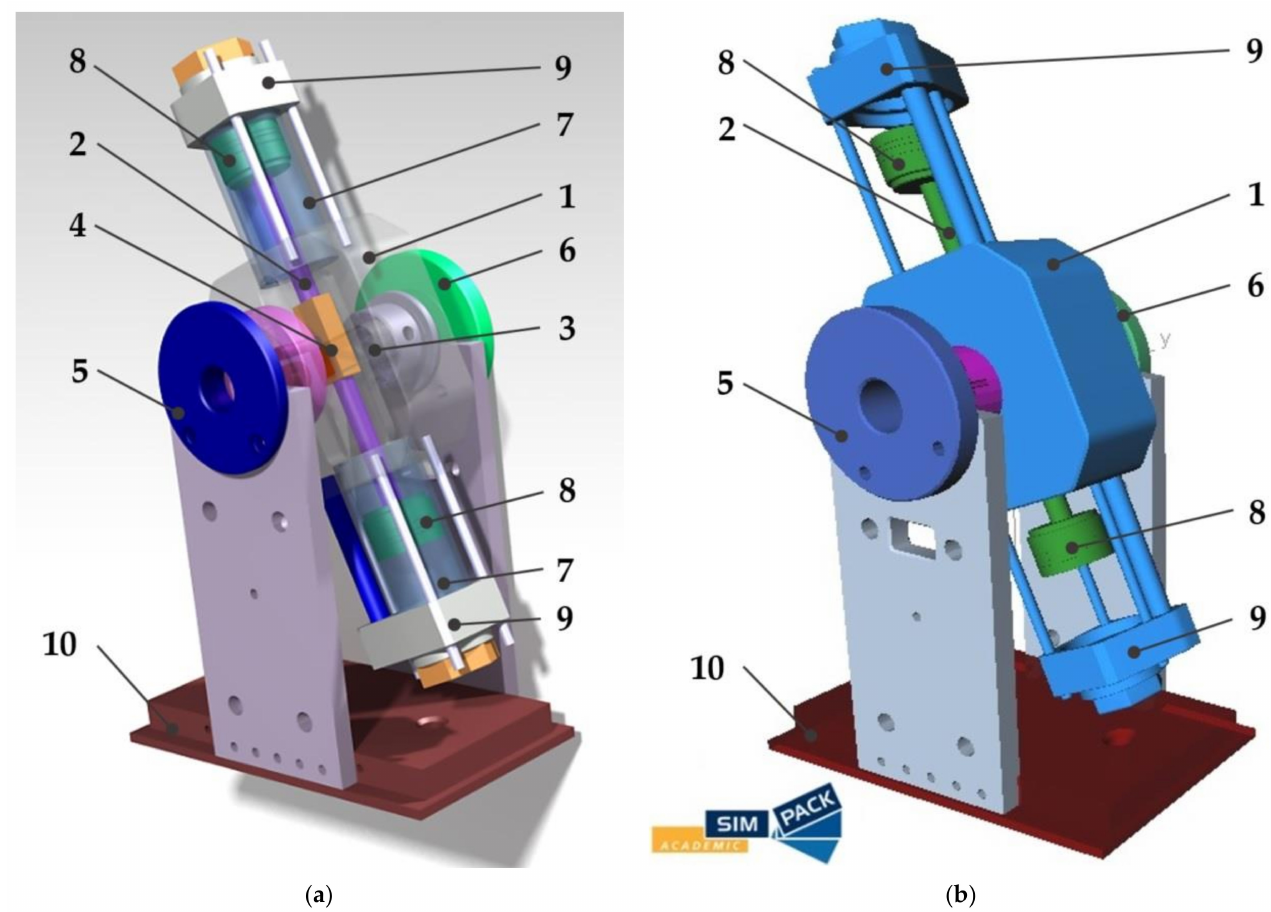
Figure 1. A non-conventional engine: ( a ) a three-dimensional model of a non-conventional engine design; ( b ) a schematic model in the Simpack software: 1—a plate, 2—a connecting rod, 3—an auxiliary stone, 4—a stone, 5—a first output, 6—a second output, 7—cylinders, 8—pistons, 9—heads of cylinders, 10—a